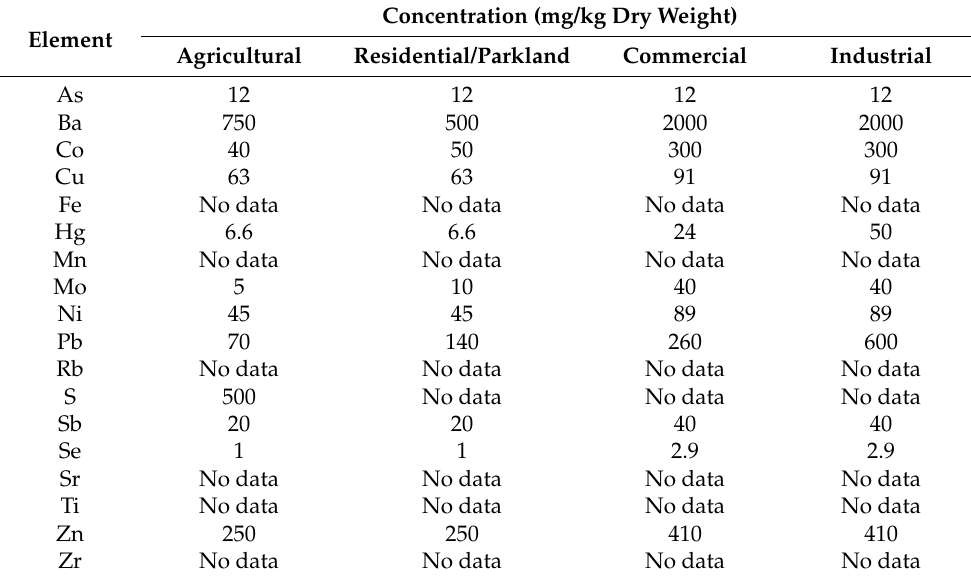
Table 7. Soil Quality Guidelines for the Protection of Environmental and Human Health. Element